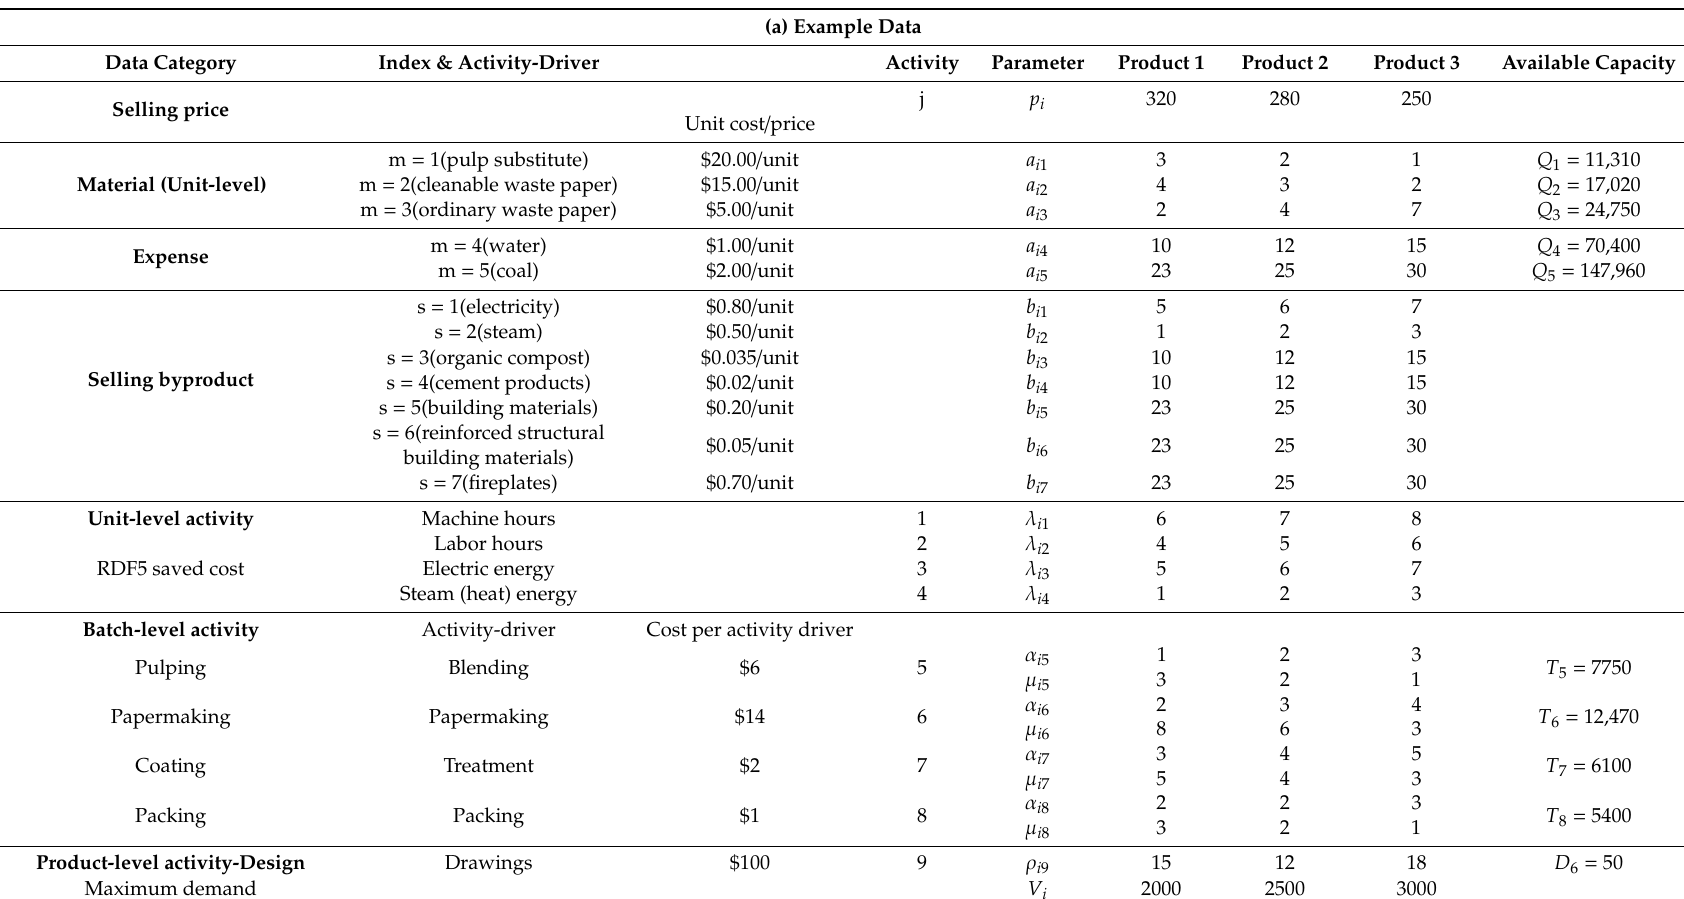
Table 1. ( a ) Example data; ( b ) Example data—facility level cost. (a) Example